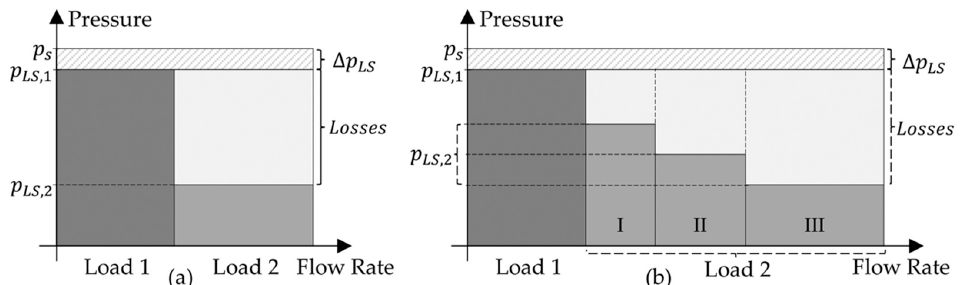
Figure 2. Flow-pressure diagram showing the effect of mode selection on resistive control losses. ( a ) With a conventional actuator; ( b ) with a multi-chamber actuator.